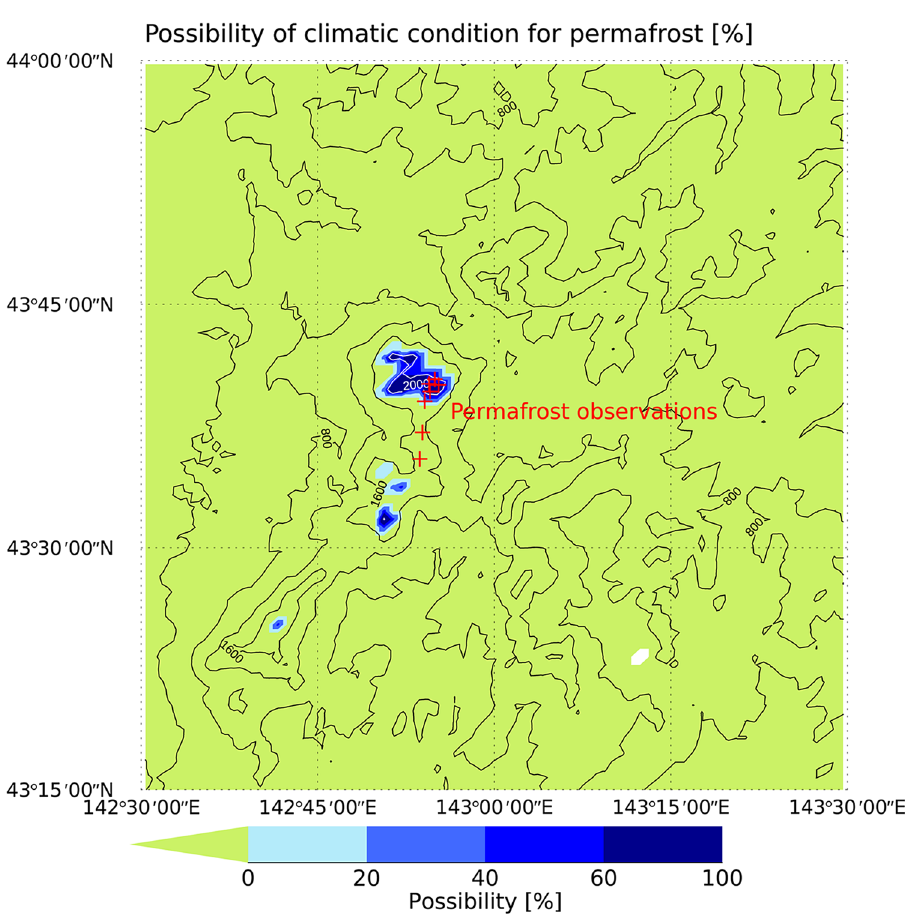
Figure 8. Same as Fig. 3, but the results for the RCP2.6 scenario for 2100 are shown. Contour lines show altitude distribution. Contour lines above and below 2000 m are shown in white and black, respectively. IDL (https:// www. l3har risge ospat ial. com/ Softw are- Techn ology/ IDL) is used to plot this